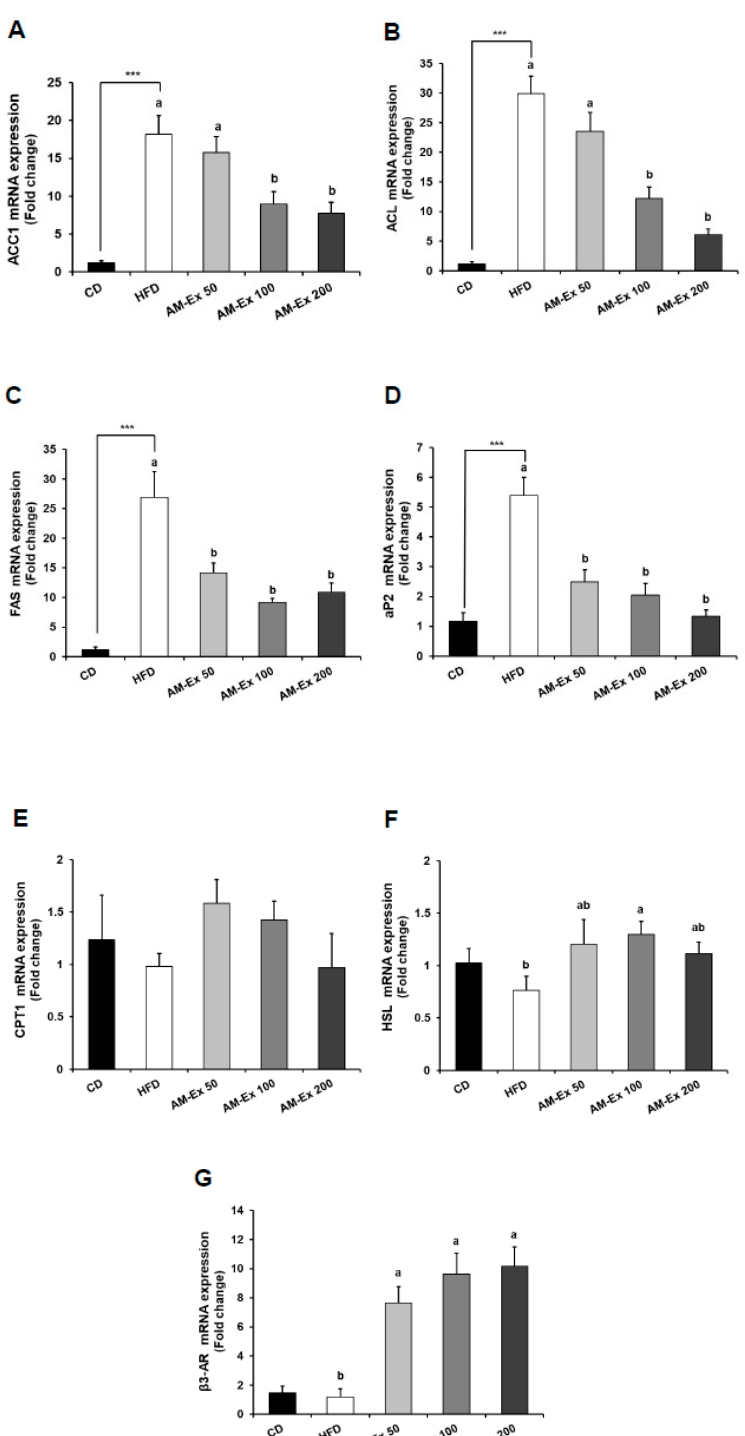
Figure 5. E ff ect of AM-Ex administration on the expression of adipogenesis-related genes in epididymal adipose tissue of HFD-fed C57BL / 6N mice. AM-Ex was administered by oral gavage for eight weeks while the mice were fed the HFD. The total RNA in epididymal adipose tissue was isolated, reverse transcribed, and real-time PCR was conducted. The amount of each mRNA was normalized to the amount of GAPDH mRNA and expressed relative to the CD group. Each bar represents the mean ± SEM (n = 10). *** P < 0.001 significantly di ff erent from the CD group. Means without a common letter di ff er between HFD, AM-Ex 50, AM-Ex 100, and AM-Ex 200 groups at P <